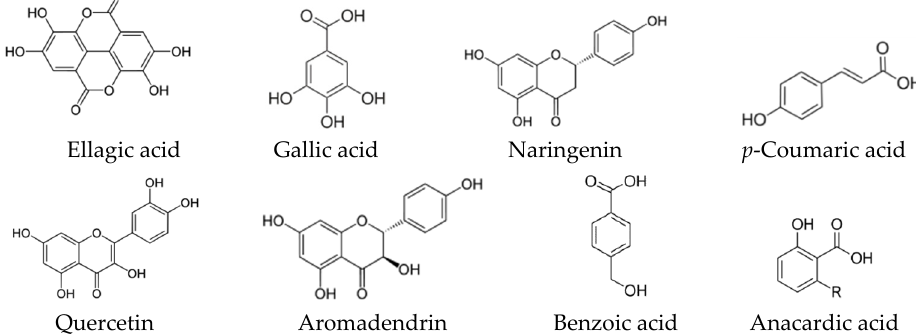
Figure 10. The major phenolic compounds that have been reported in SBPs